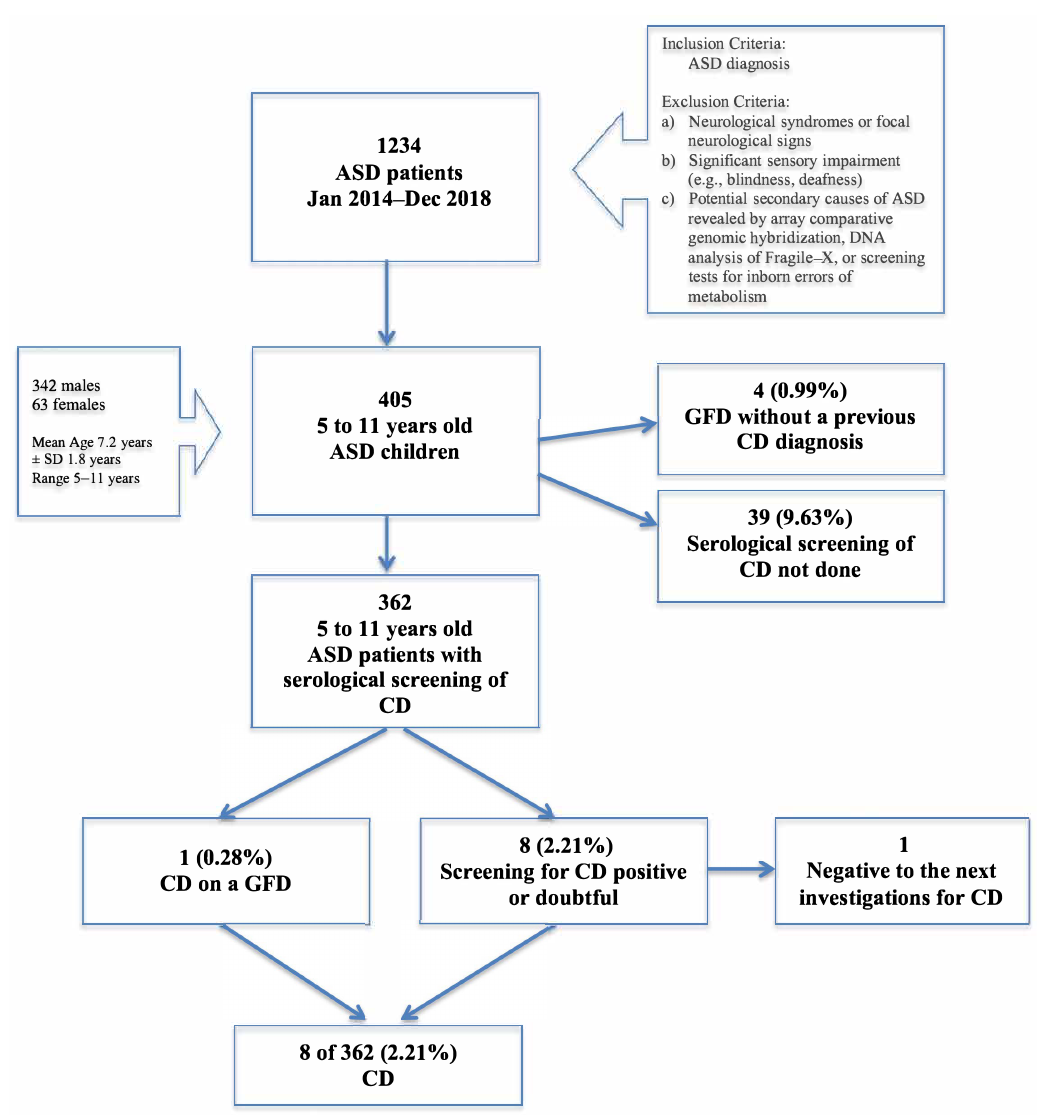
Figure 1. Study flow-chart. Abbreviations (alphabetic order): ASD, Autism Spectrum Disorders; CD, celiac disease; GFD, gluten-free diet; SD standard